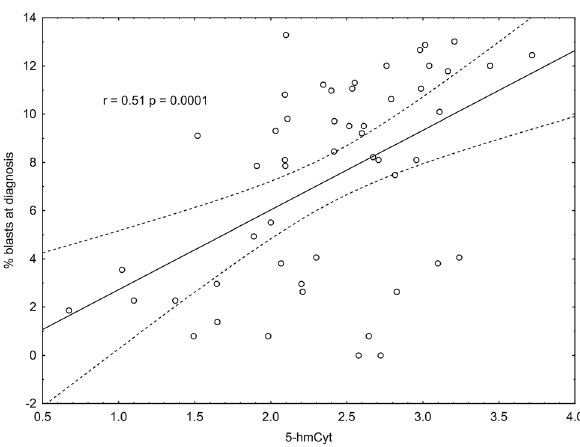
Figure 3. Correlation between 5-hydroxymethylcytosine and % blasts at